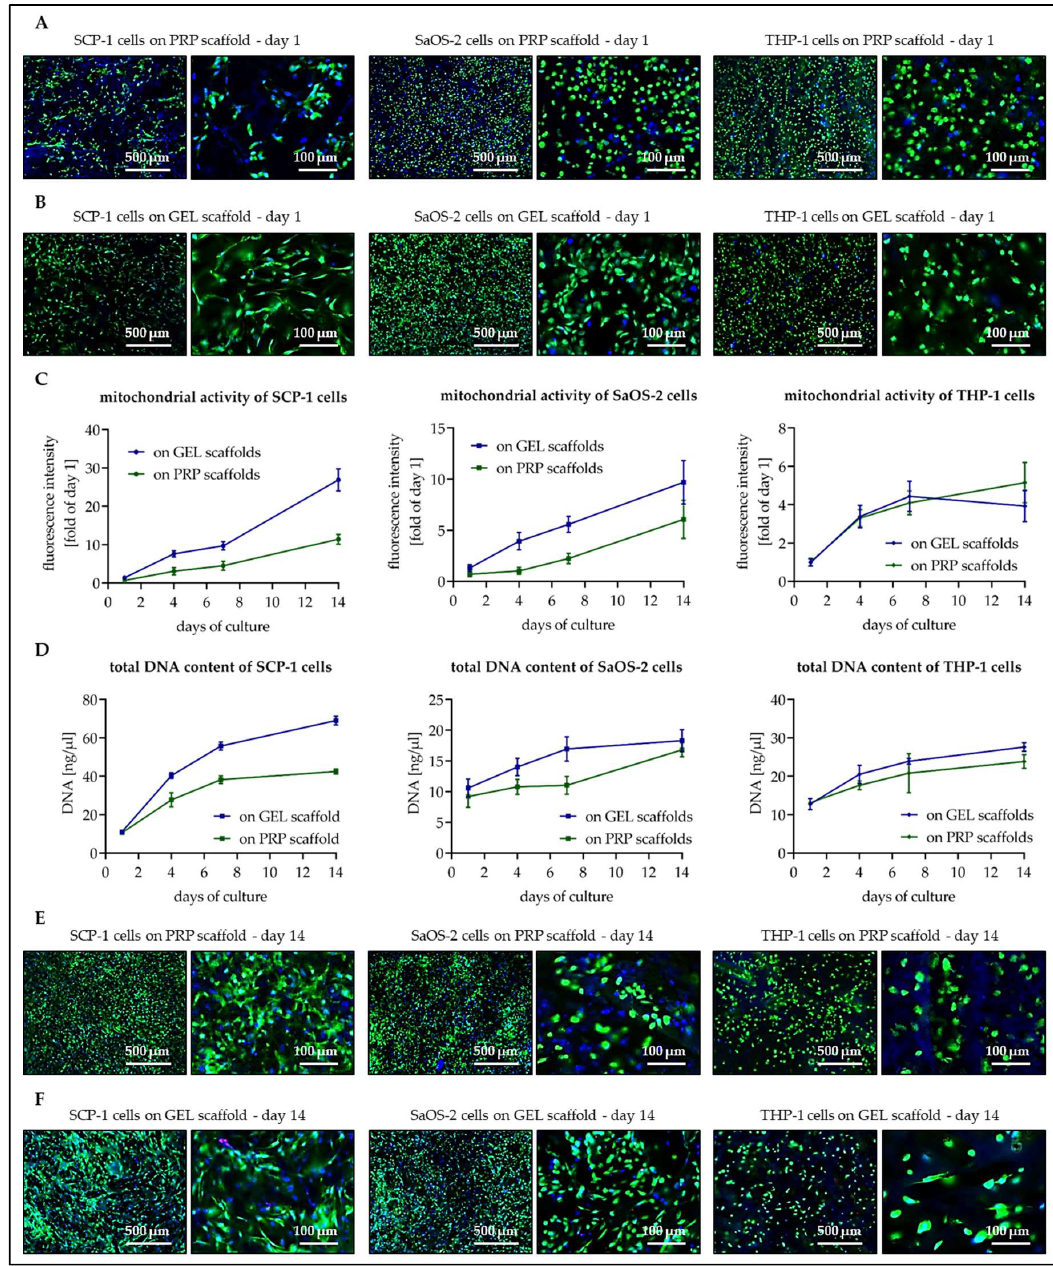
Figure 4. Viability of the different cell types over time on the two scaffold types. Twenty thousand SCP-1 cells, 4 × 10 4 SaOS-2 cells, and 8 × 10 4 THP-1 cells were plated per scaffold. ( A , B ) Twenty-four hours after seeding, ( E , F ) as well as after 14 d of differentiation, cells on the scaffolds (( A , E ) PRP scaffolds and ( B , F ) GEL scaffolds) were visualized by live–dead staining: green cytoplasm in all living cells (calcein-AM), blue nuclei in all cells (Hoechst 33342) and red nuclei in all dead cells (Ethidium bromide). On days 1, 4, 7, and 14 of differentiation ( C ) mitochondrial activity was determined by resazurin conversion and ( D ) the amount of total DNA was determined by absorbance measurement. Each experiment was performed three times (N = 3) in triplicates (n = 3).